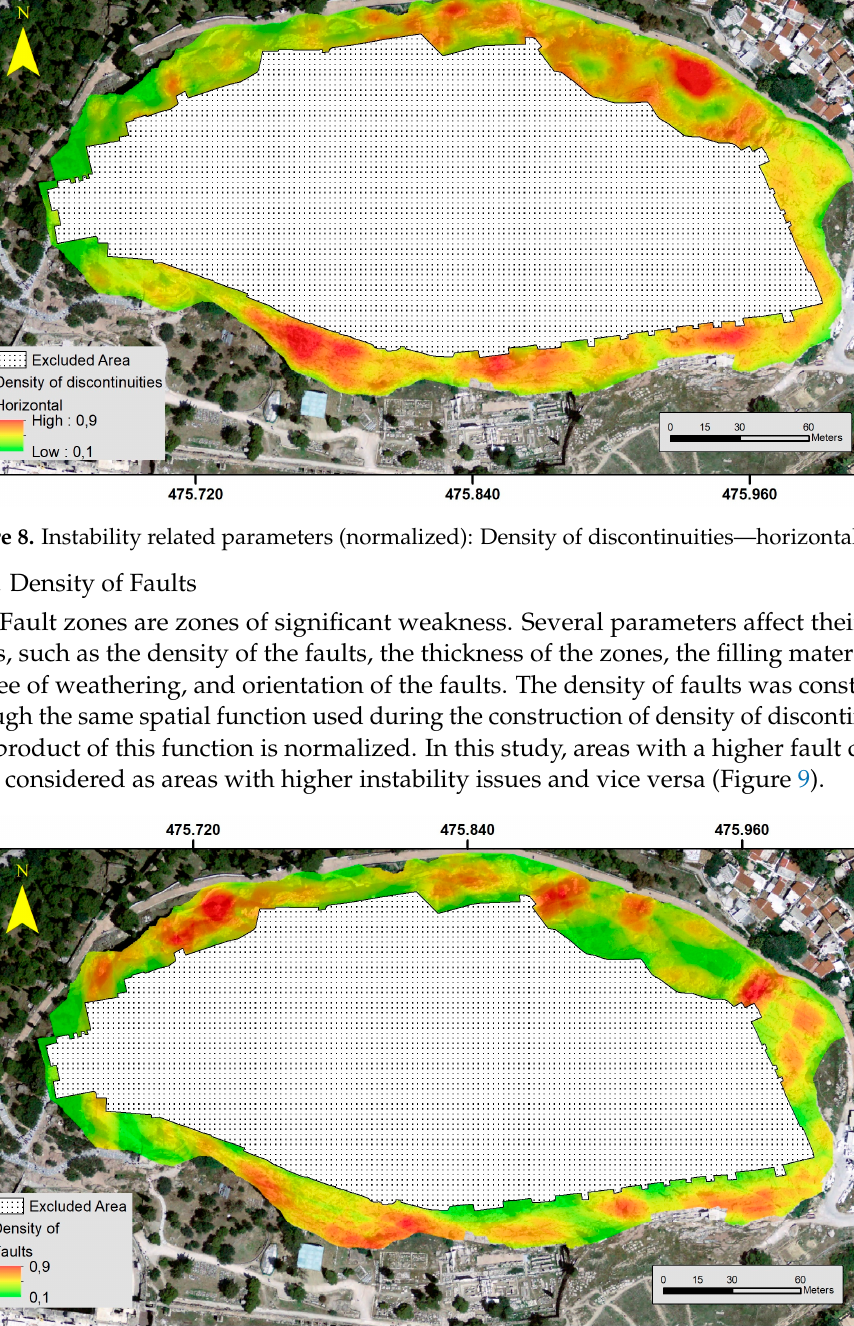
Figure 7. Instability related parameters (normalized): Density of discontinuities—vertical.